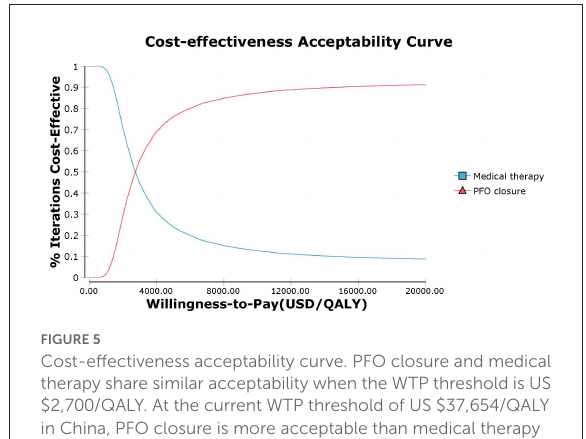
FIGURE5 Cost-effectiveness acceptability curve. PFO closure and medical therapy share similar acceptability when the WTP threshold is US $2,700/QALY. At the current WTP threshold of US $37,654/QALY in China, PFO closure is more acceptable than medical therapy